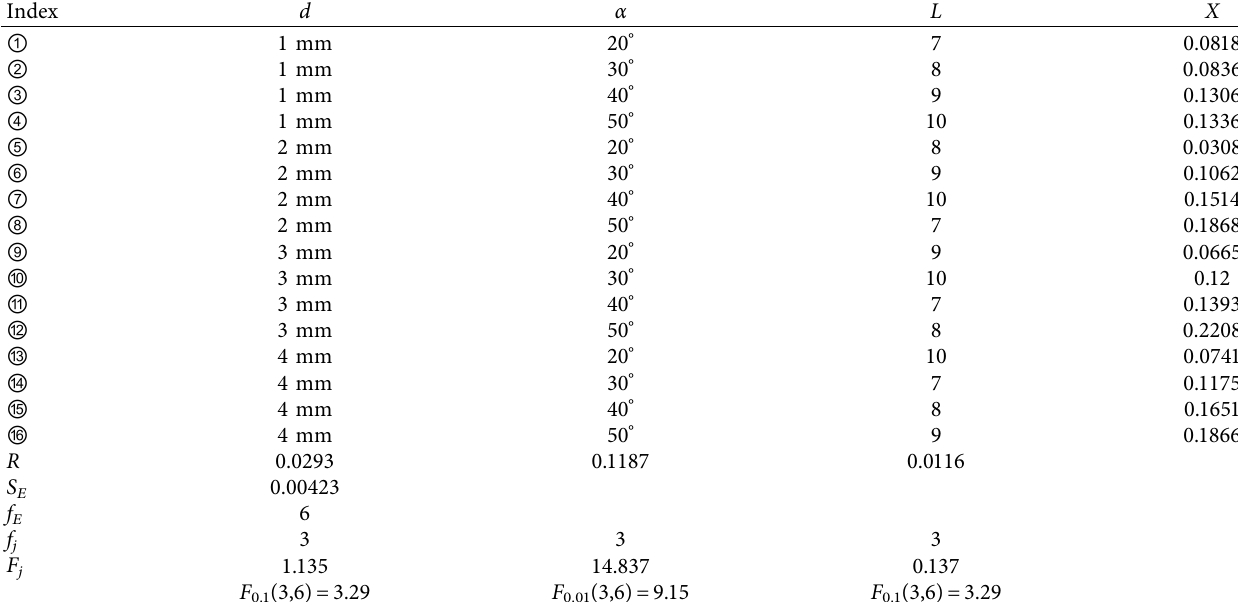
Table 6: Analyses of variance and range for nozzle parameters.